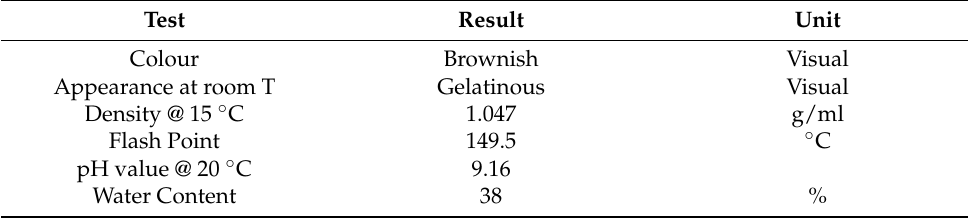
Table 13. Glycerine produced